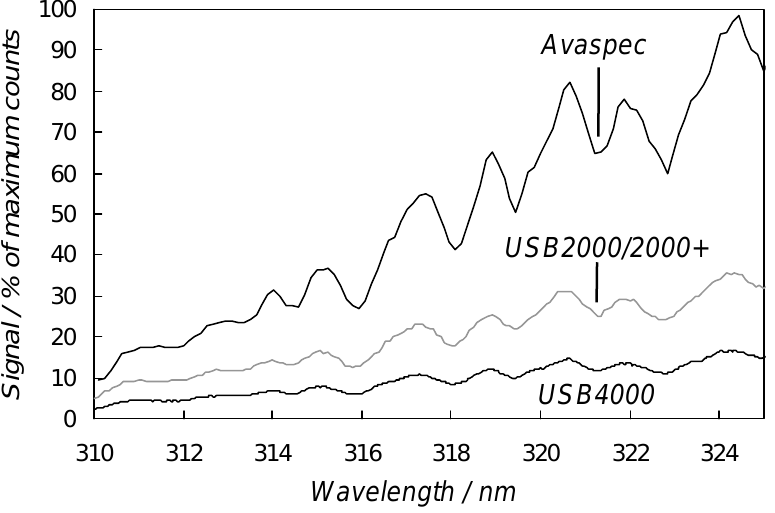
Figure 2. Skylight spectra for simultaneous identical exposure time (170 ms)